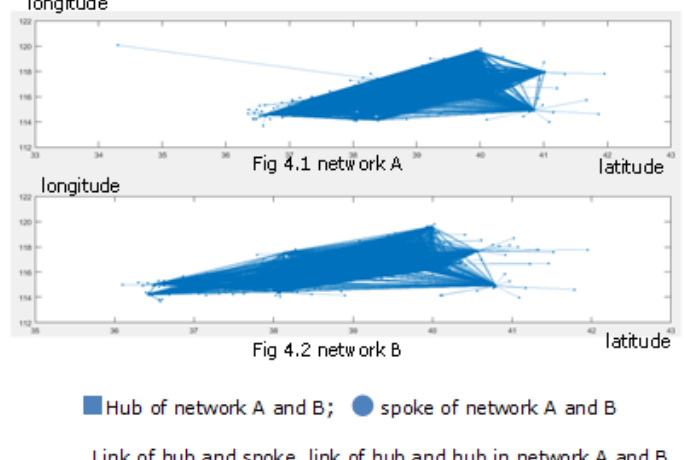
Figure 3. The hub and spoke network in the northern region, r = 1,  = 0.5